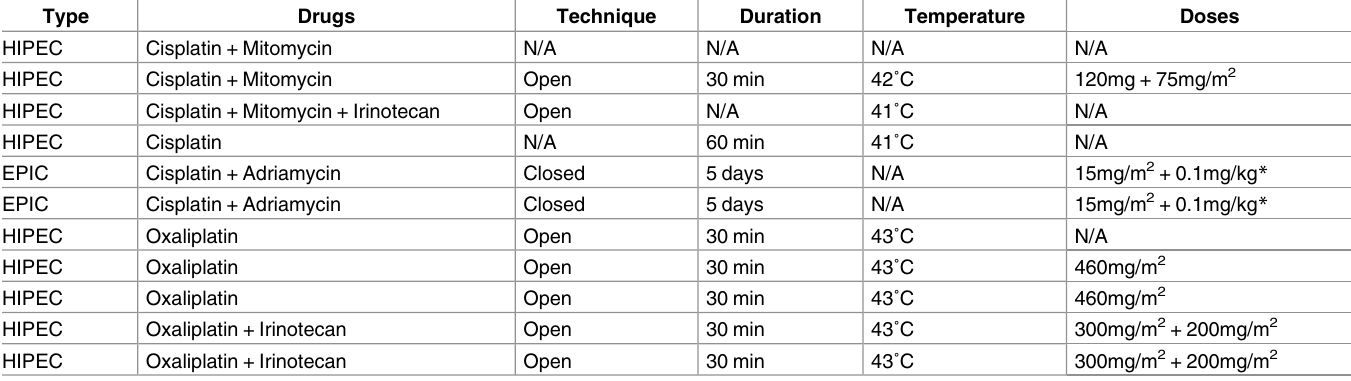
Table 2. Intraperitoneal